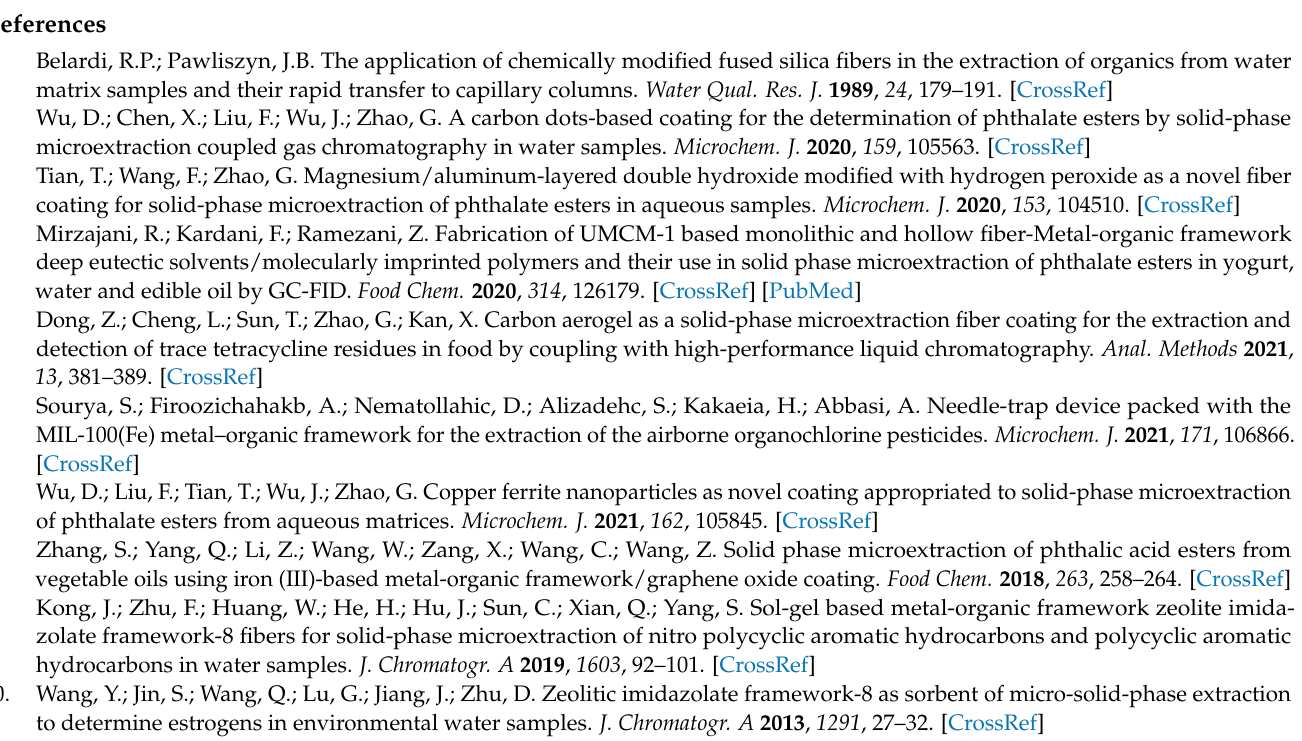
extraction/desorption. Table S1: Structure and some physicochemical properties of PAEs; Table S2: The compositions of the synthesis mass ratio of the product; Table S3: Pore structure parameters of the sample; Table S3: Pore structure parameters of the sample; Table S4: Comparison of the established method with the other reported methods for detection